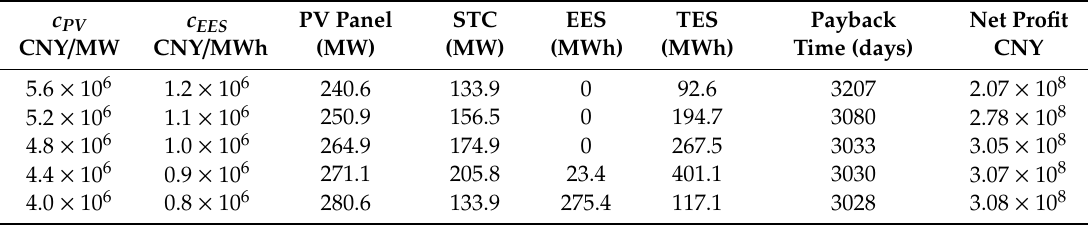
Table 4. Optimal sizing strategies with di ff erent costs of solar panel and